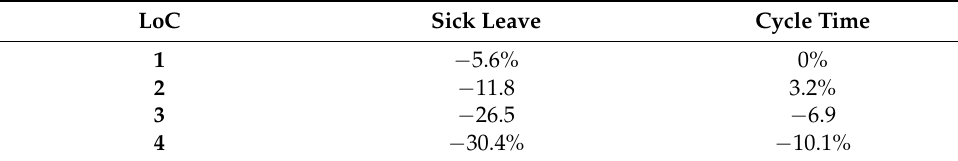
Table 7. Comparison of sick leave and productivity for different LoC.